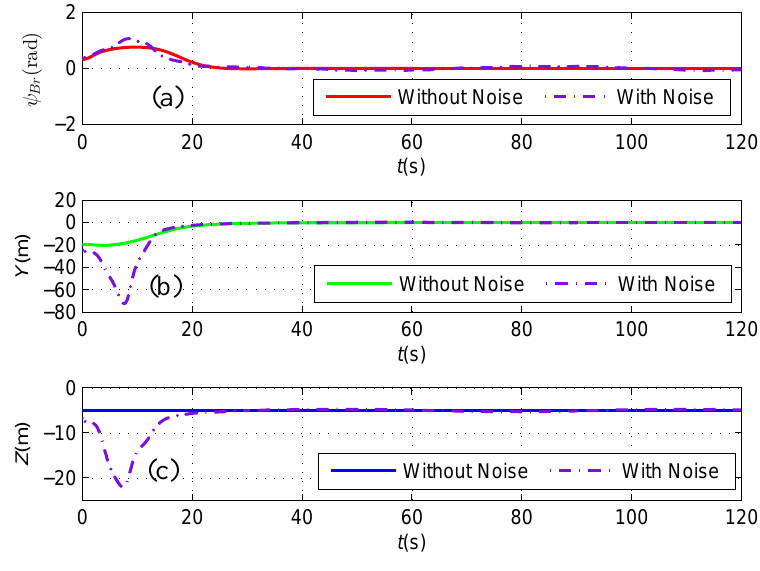
Figure 16. ( a ) The angle ψ Br between the AUV heading and the direction of the cable; ( b ) The horizontal offset Y between the AUV and the cable; and ( c ) The vertical distance Z between the AUV and the cable. Two simulation cases are plotted in the same figure, in which the solid line and dot-dashed line represent the error without noise and the error with noise,